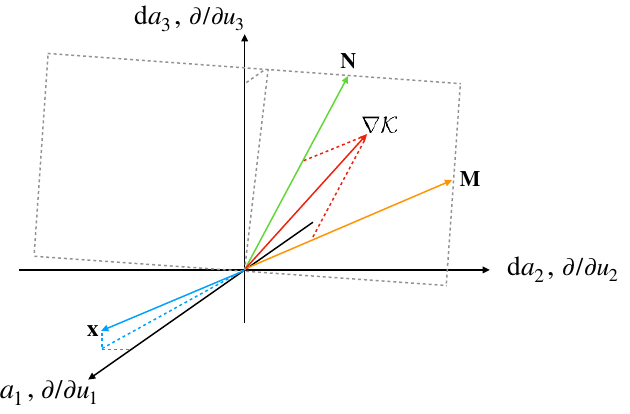
Figure 4 . The light axionic direction x is aligned with the a 1 -axis. The hierarchy jA 1 j (cid:28) jA 2 j ; jA 3 j is apparent since the plane spanned by the (cid:13)ux vectors is nearly parallel to the a 2 - a 3